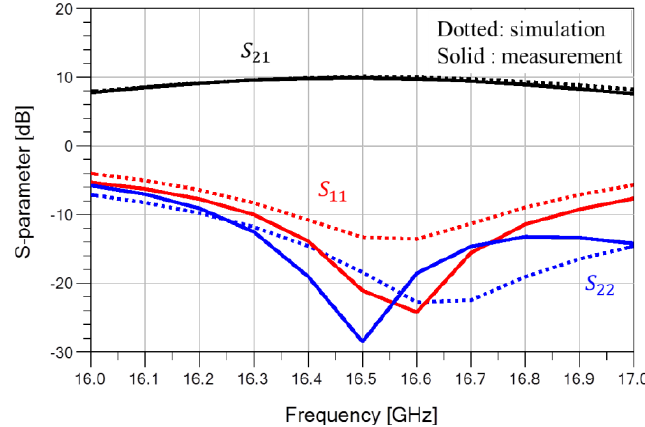
Figure 8. Simulated and measured S-parameter results (simulation: dotted lines, measurement: solid lines).